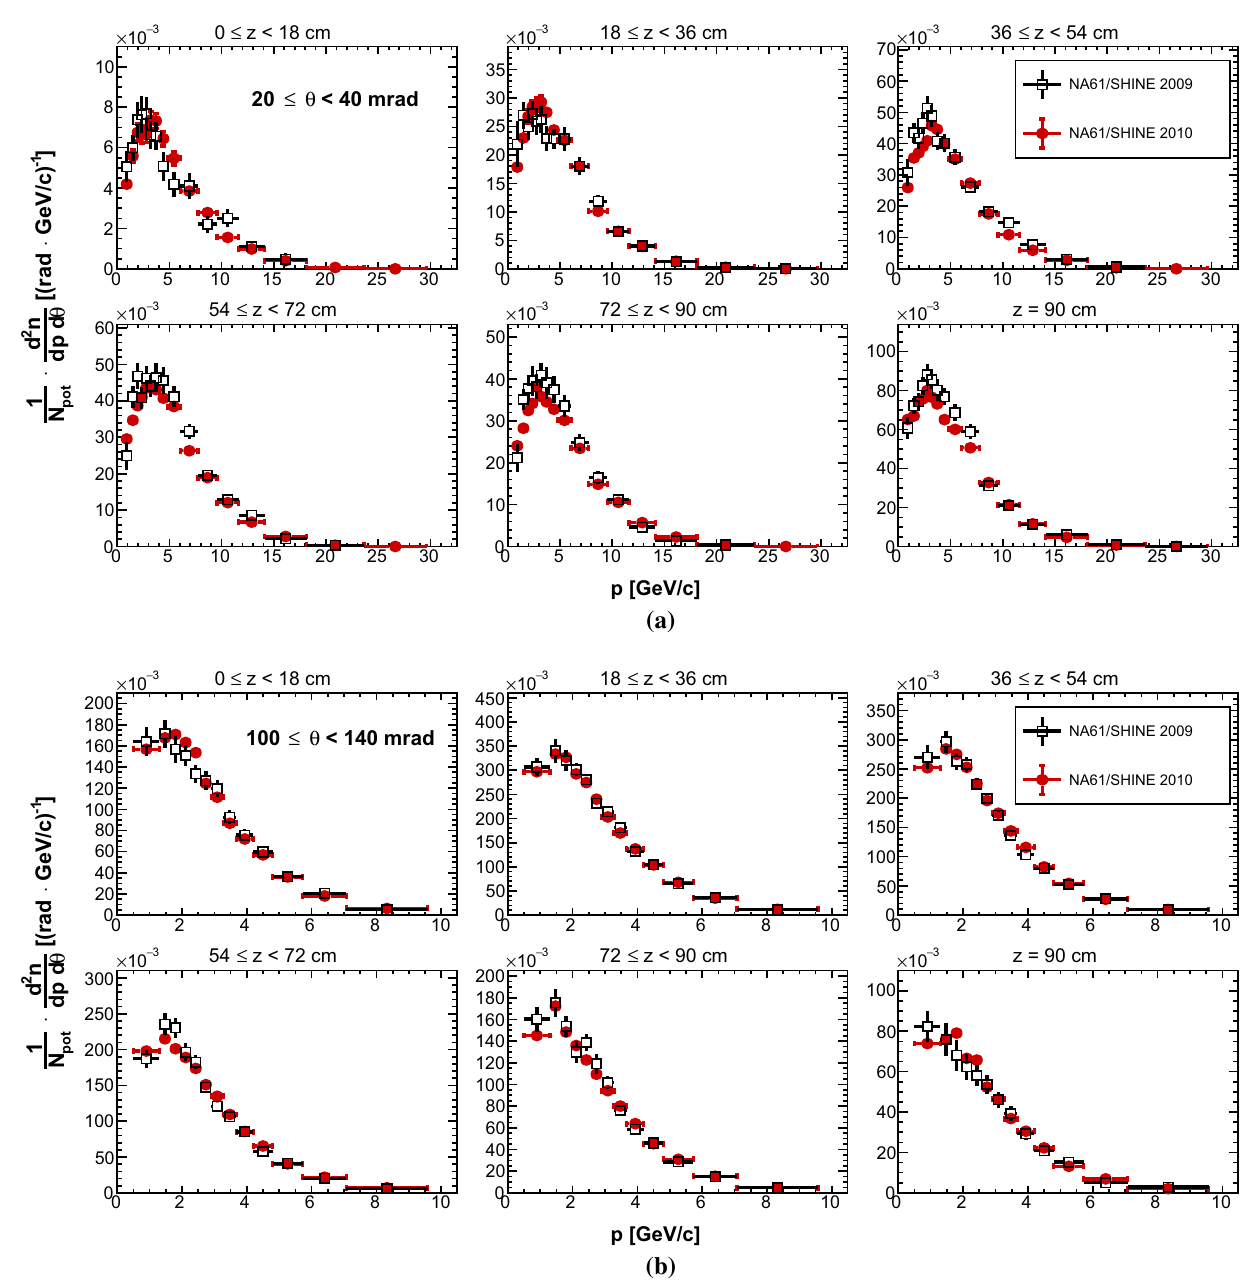
Fig. 54 Double differential yields of negatively charged pions as a functionofmomentumforthepolaranglebetween20mradand40mrad ( a ) and between 100mrad and 140mrad ( b ). Each panel shows a differ-